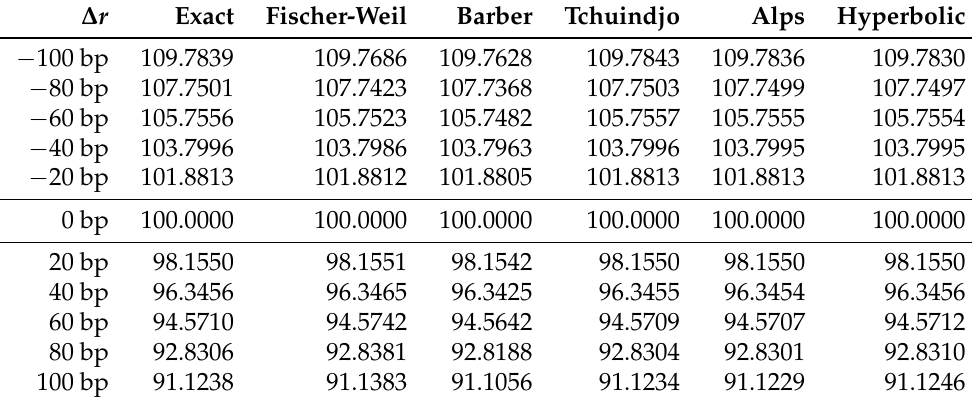
Table 4. PV of 10-year par bond with coupon rate r 0 .